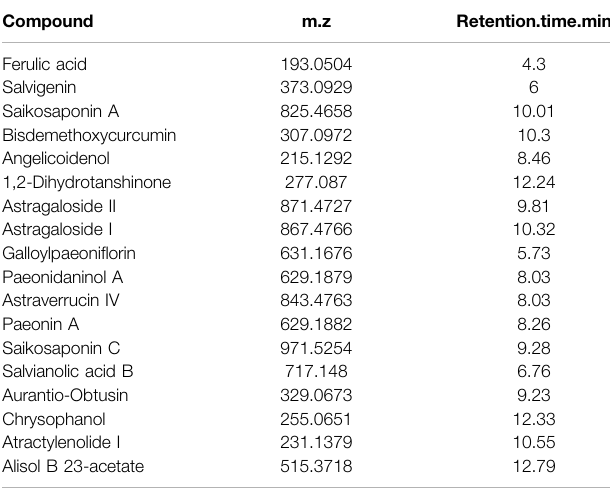
TABLE 2 | The components identi fi ed in